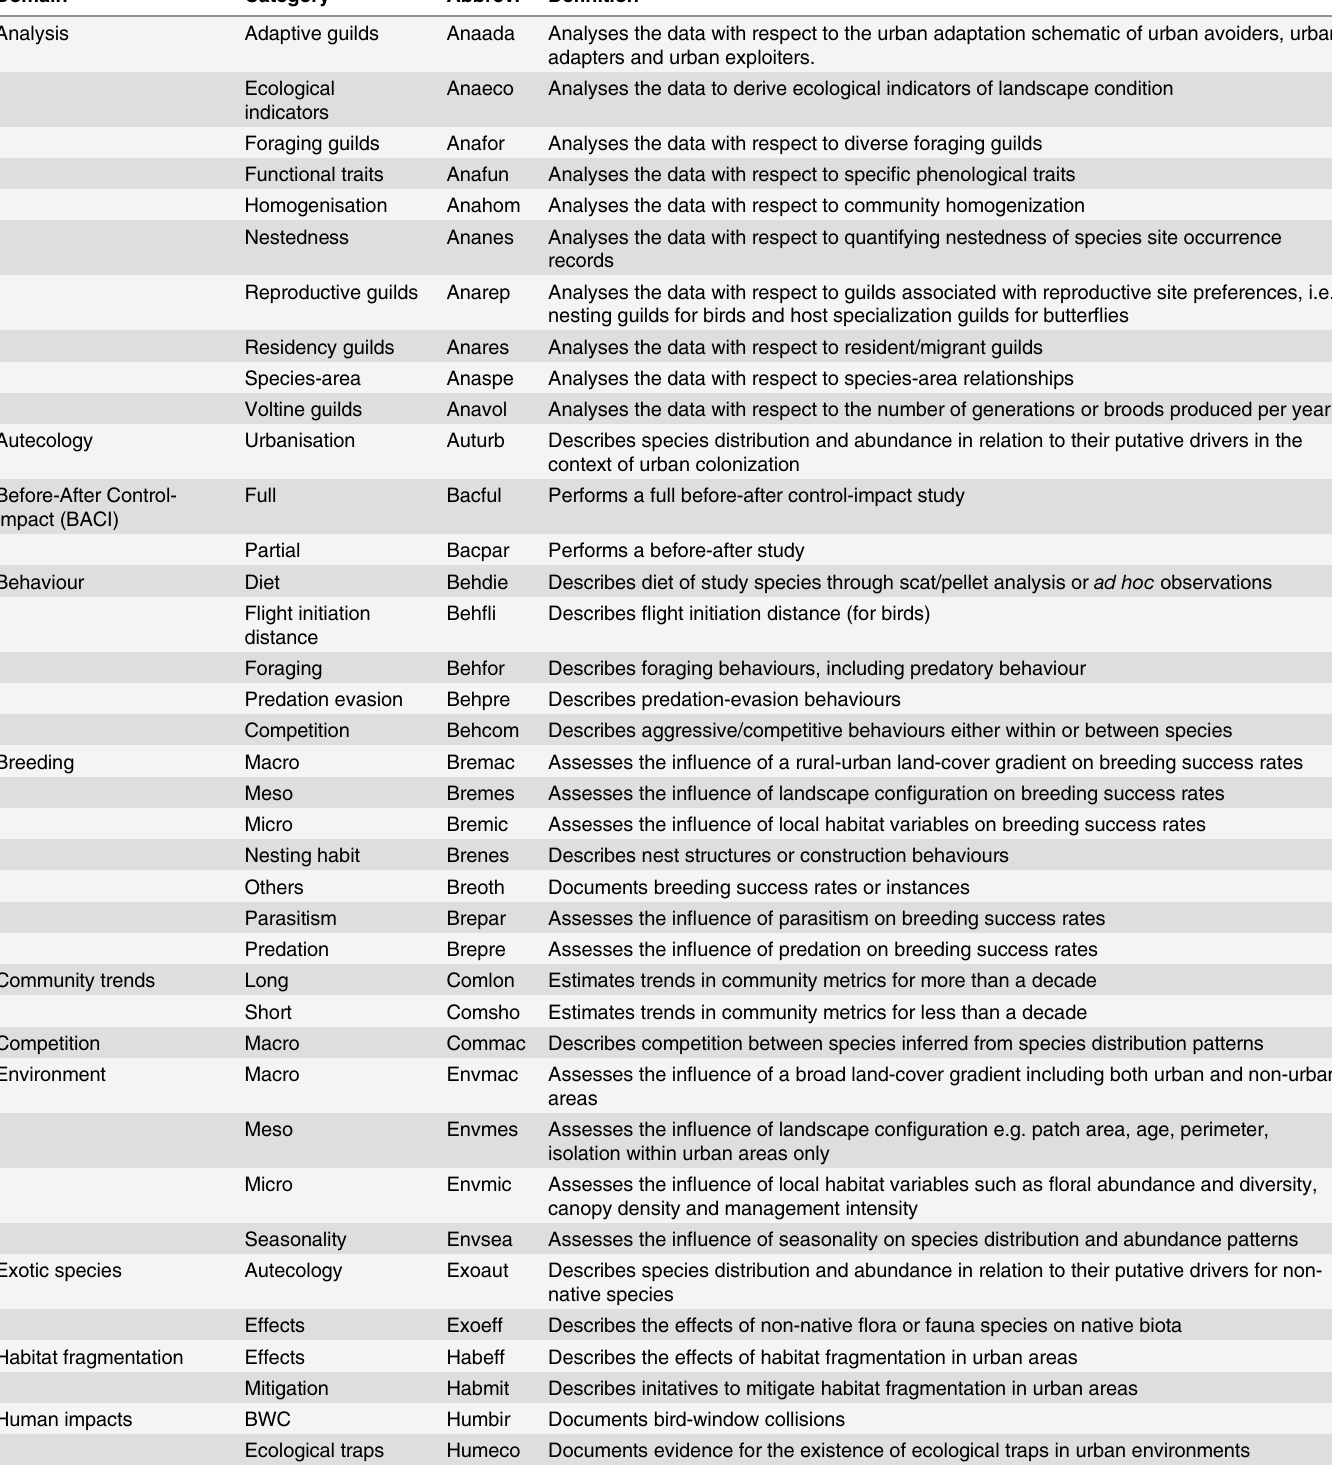
Table 2. Description of 19 research domains and 61 research categories (sub-domains) identified from 624 scientific papers selected for review as relevant for the urban ecology of birds and butterflies, published between 2005 and 2014.